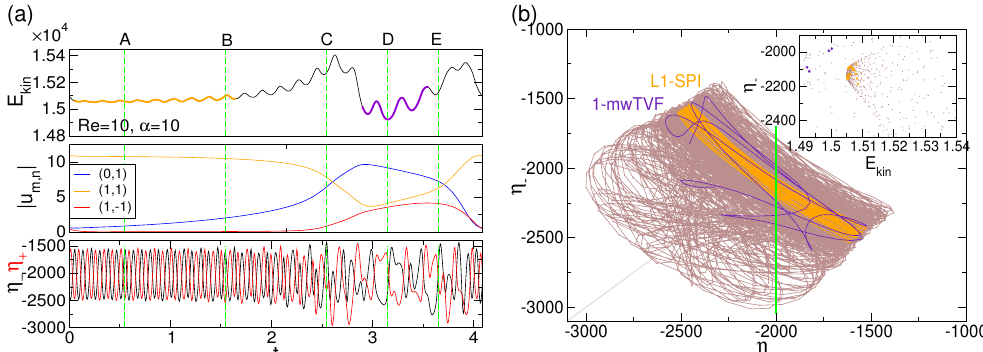
Figure 11. ( a ) Extraction of Figure 10 illustrating one single period of the heteroclinic connection (hco). ( b ) Phase portrait in ( η + , η − ) plane (see text for further description). Exemplarily, orange and violet colors indicate the L1-SPI and 1-mwTVF, respectively, extracted from longtime sequence (brown color) of the flow dynamics (same color code is used in ( a , b )). The inset shows the corresponding Poincaré section ( η − , E kin ) for η + = − 2000 (vertical green line in ( b )). The dashed green lines with labels (A)–(E) illustrate time steps for which flow visualizations are shown in Figure 12. Control parameters: Re = 10, α =